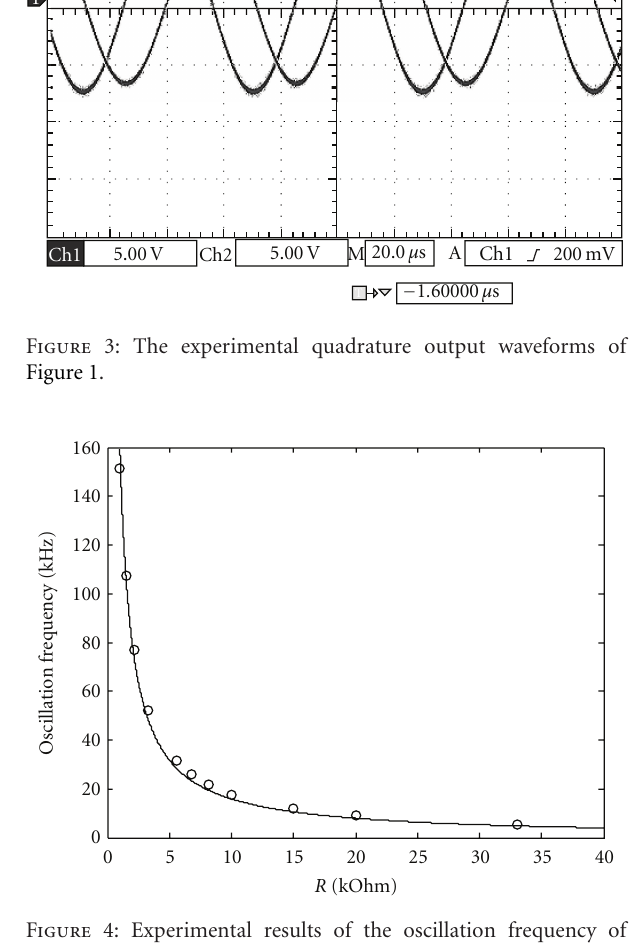
Figure 6: Experimental results of the oscillation frequency of Figure 2, which is obtained by varying the value of R; o o o, experi- mental results; —, ideal